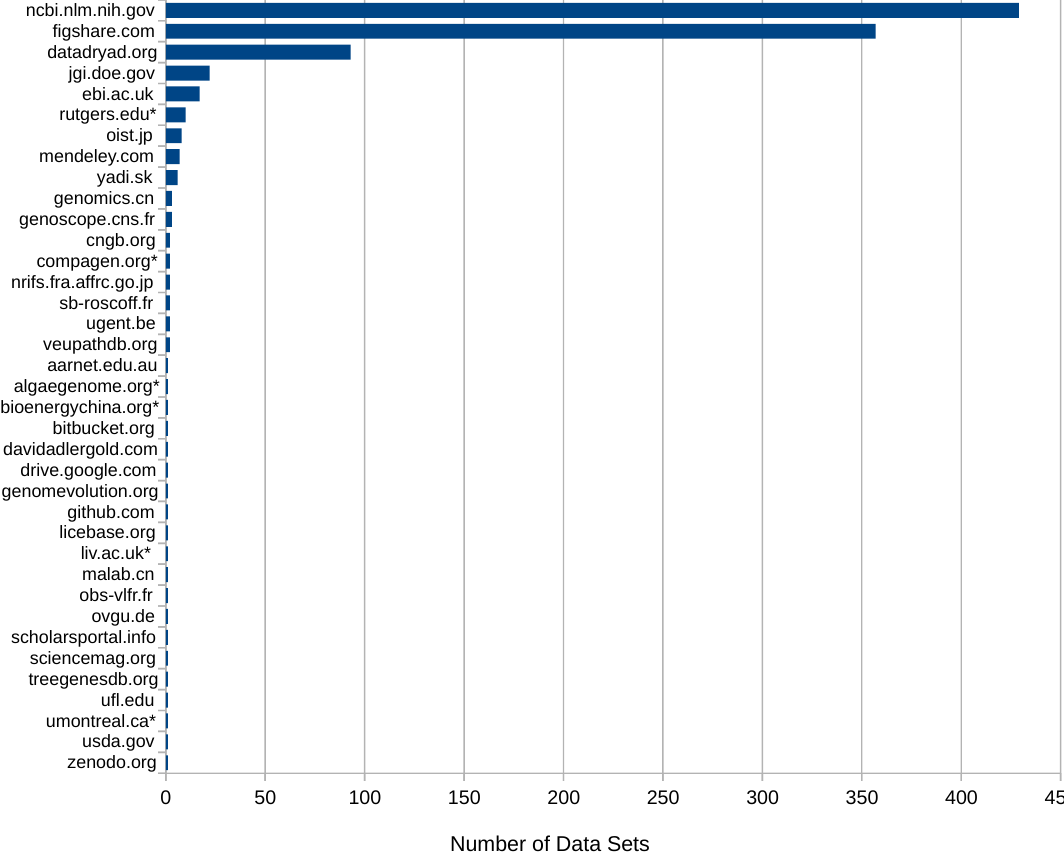
Figure 2: the 37 different web hosts from which data sets were downloaded. The count for figshare.com includes 272 species from the MMETSP (Keeling et al., 2014) for which a procedure to remove cross-contamination was applied (Marron et al., 2016). Individual URLs for each data set are listed in the metadata files available on FigShare. * indicates that the URLs for one or more data sets point to servers that are no longer responding or are otherwise